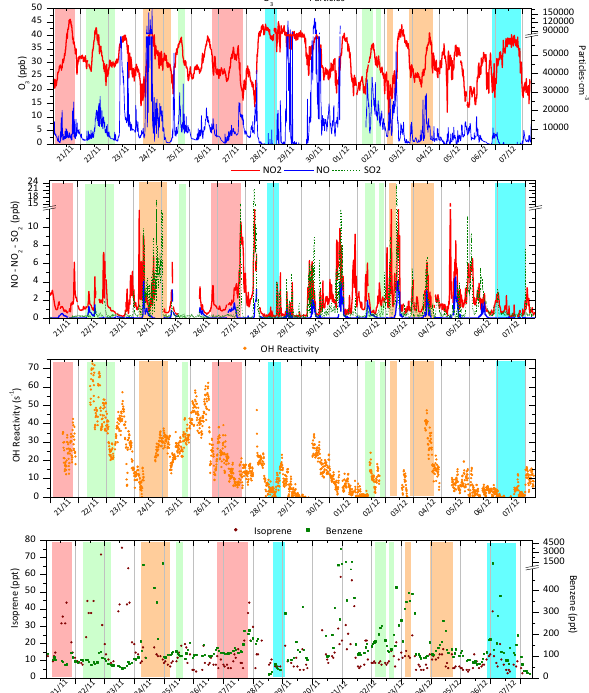
Fig. 6. Mixing ratios of ozone, NO, NO 2 , SO 2 , particle concentra- tions, total OH reactivity (10min data), isoprene and benzene mix- ing ratios (hourly data) throughout the DOMINO campaign. Peri- ods classified into distinct sectors of air mass origin are marked by brown (Huelva–Portugal), green (continental–north), red (Seville– Guadalquivir) and blue (marine) shaded areas.